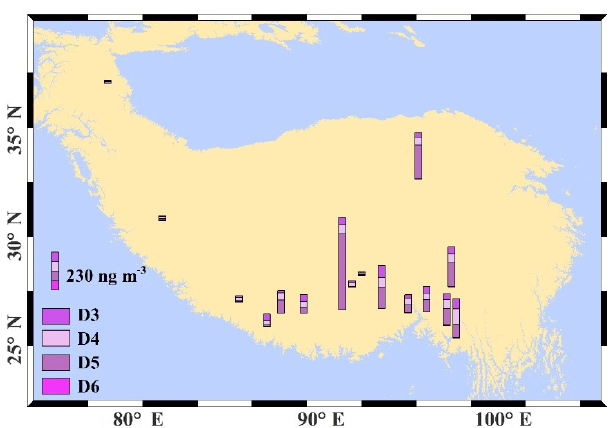
Figure 2. Spatial distribution of cVMSs in the atmosphere of the